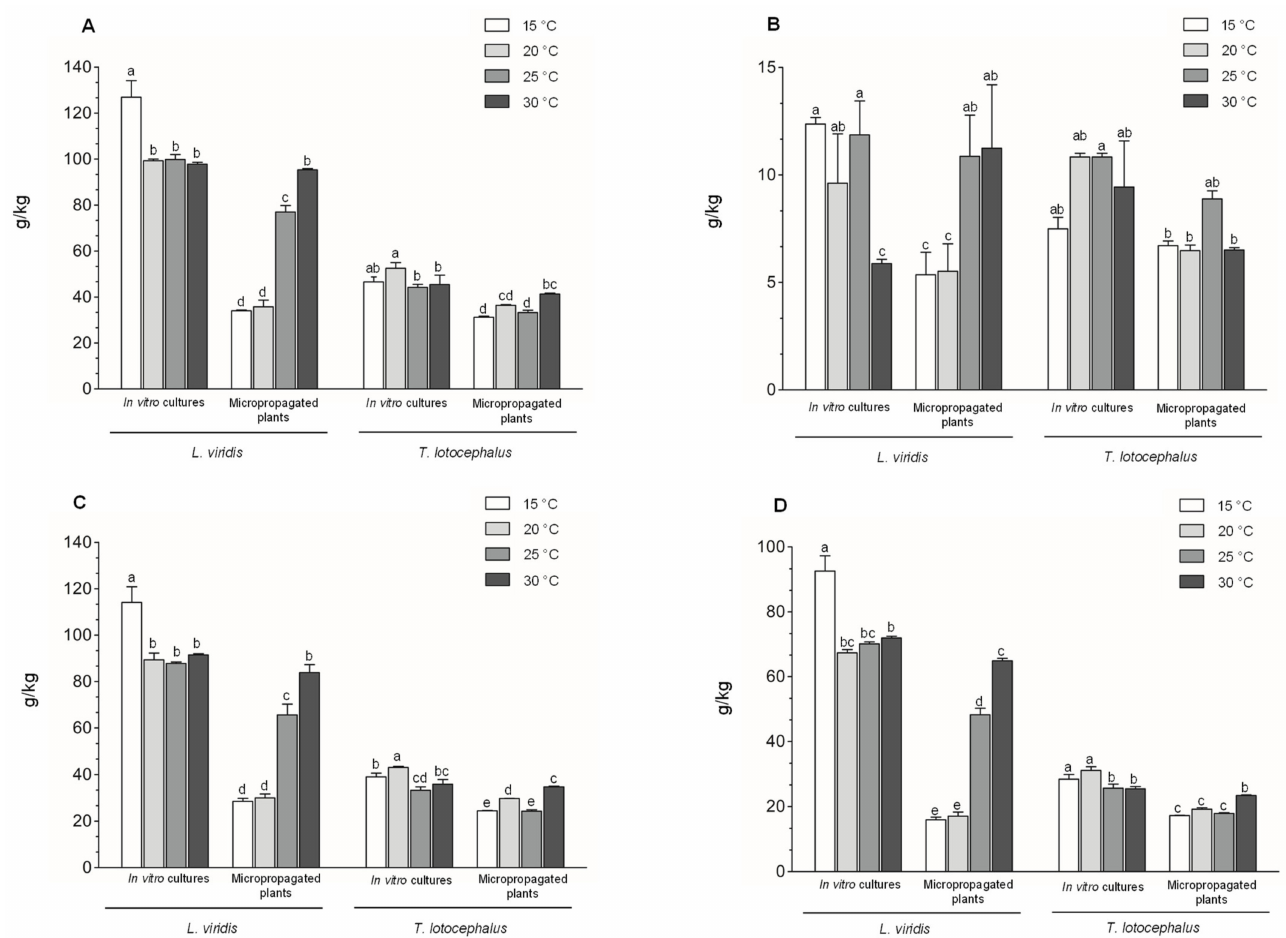
Figure 3. Effect of exposure to different temperatures (15, 20, 25, and 30 ◦ C) on ( A ) total phenolic content, ( B ) total flavonoid content, ( C ) total phenolic acids content, and ( D ) total rosmarinic acid content determined by HPLC-HRMS of in vitro cultures and micropropagated plants of Lavandula viridis and Thymus lotocephalus . For each species, the results were analyzed by one-way analysis of variance (ANOVA) and the graph bars followed by different letters (a–e) are significantly different at p < 0.05 (Duncan’s New Multiple Range